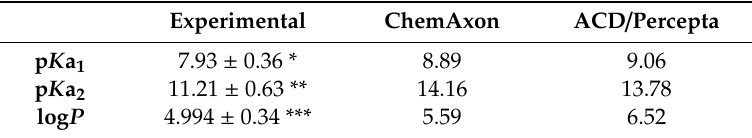
Table 4. Experimental and computer calculated p K a values of 2c